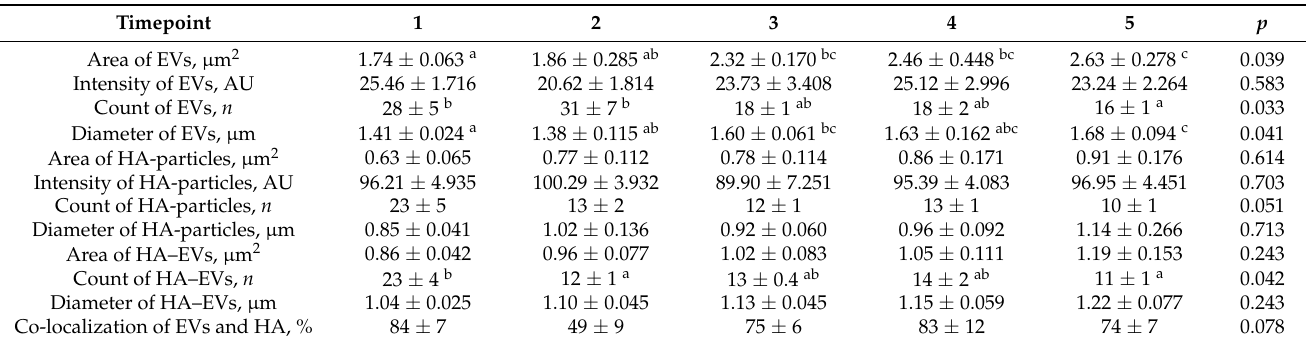
Table 1. Confocal microscopy data of EVs released by fibroblast-like synoviocytes into conditioned media at timepoints 1–5 (mean ± SE).